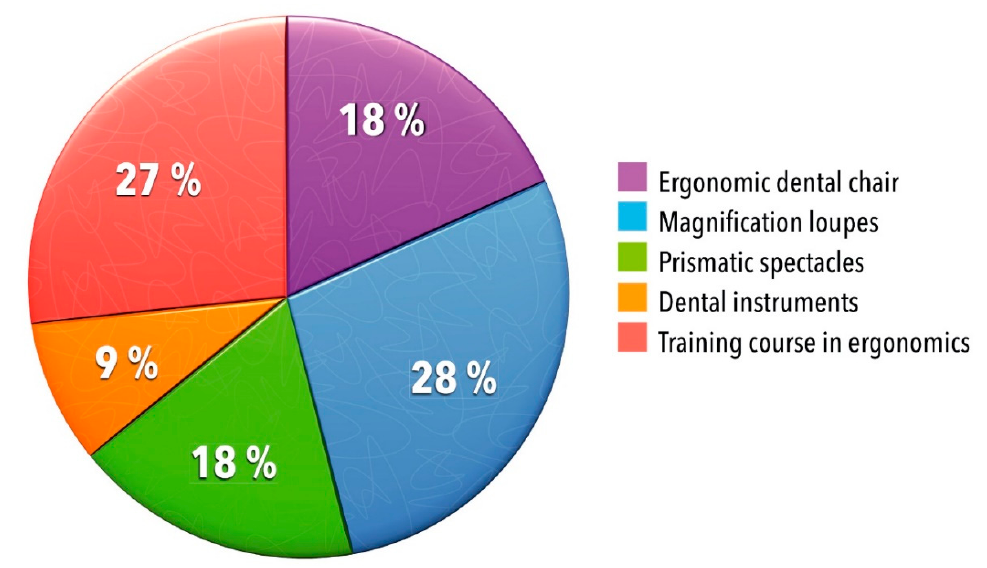
Figure 2. Subjects of ergonomic interventions to prevent MSDs among dental professionals ( n = 11).